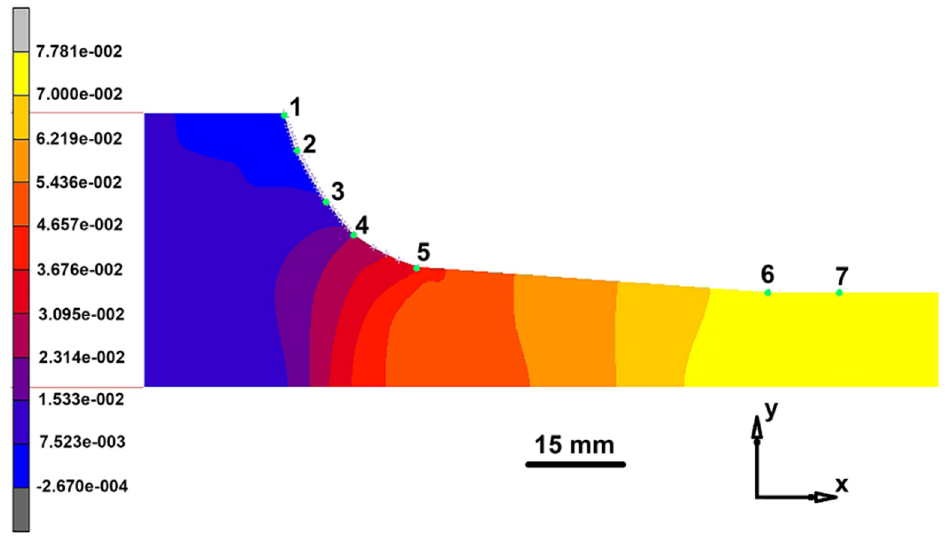
Figure 4. Distribution of plastic flow velocity V during extrusion of 30 mm rod at time 360 s from process start. Values for color isocontours correspond to mass flow velocities V × 0.1 mm/s.